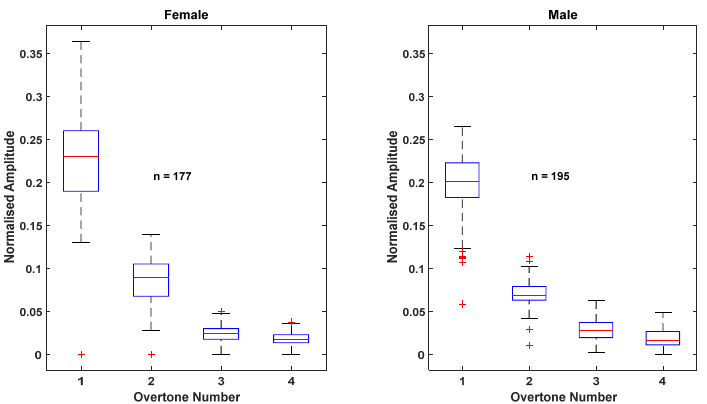
Figure 8. Distributions of normalized harmonic amplitudes of first four overtones for all female and male trials.